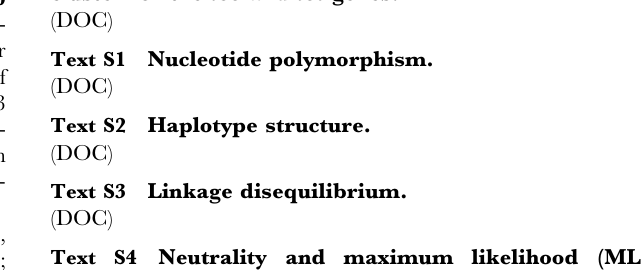
Table S1 Nucleotide diversity and divergence in the lbe gene region of D. melanogaster . Table S2 Nucleotide diversity and divergence in the lbl gene region of D. melanogaster . Table S3 Nucleotide diversity and divergence in the ladybird gene region of D. melanogaster . Table S4 Recombination estimates ( r ). Table S5 Gene conversion events in the lbe and lbl genes of D. melanogaster . Table S6 Linkage disequilibrium between functional regions of the lbe and lbl genes. Table S7 Kelly’s (Kelly 1997) and Wall’s (Wall 1999) tests of neutrality for the lbe and lbl gene regions. Table S8 Statistical significance of the binding site cluster for the lbe and lbl